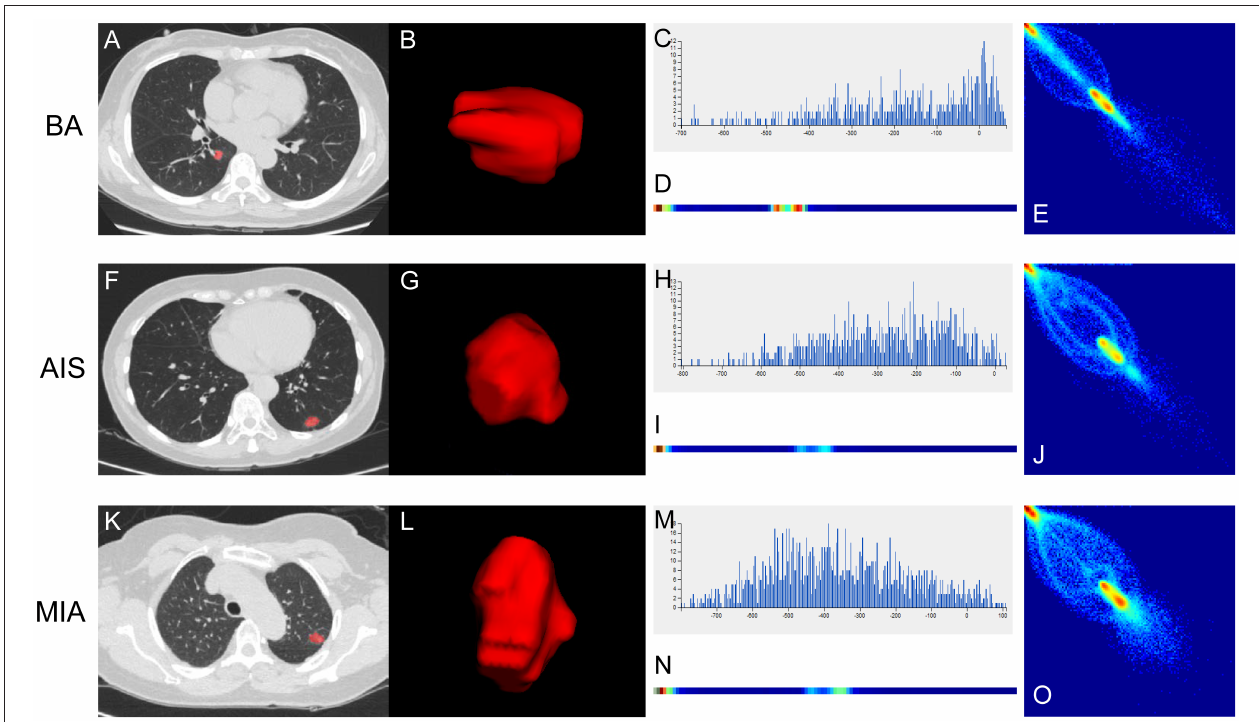
FIGURE 2 | Three representative sets of CT texture features of patients with BA (A–E) , AIS (F–J) , and MIA (K–O) . (A,F,K) Thin-section unenhanced CT images. (B,G,L) VOIs delineated by the ITK-SNAP software. (C,H,M) Histograms of texture parameters of the three lesions showed a marked difference. The distribution of (H) and (M) were more dispersed than the distribution of (C) . (D,I,N) GLRLM features of the three lesions. The frequency of grayscale changes of (D) was more stable than that of (I,N) . (E,J,O) GLCM features of the three lesions. The distribution of (E) was more concentrated than the distribution of (J,O)